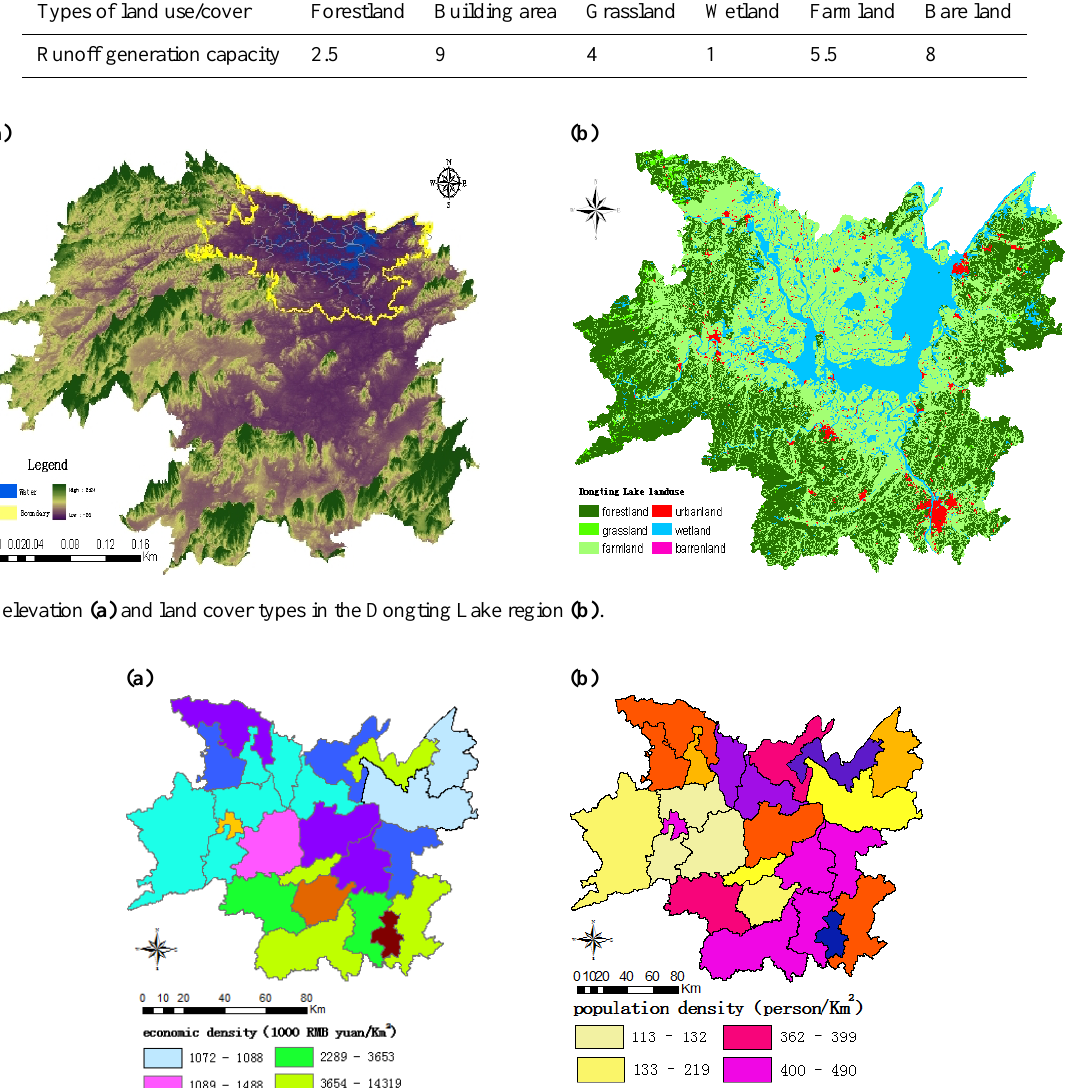
Fig.7.The flood affected area(left),suffered population(middle) and economic loss(right) regional variation Fig.8. Spatial and temporal DMUS determination Output Input Input Input